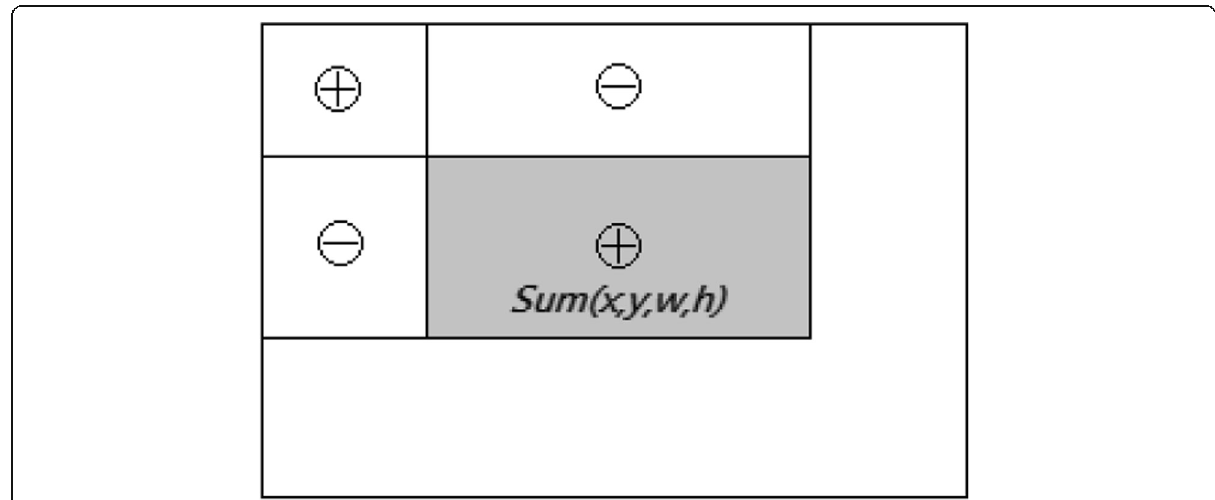
Fig. 7 Integral image of a certain rectangular